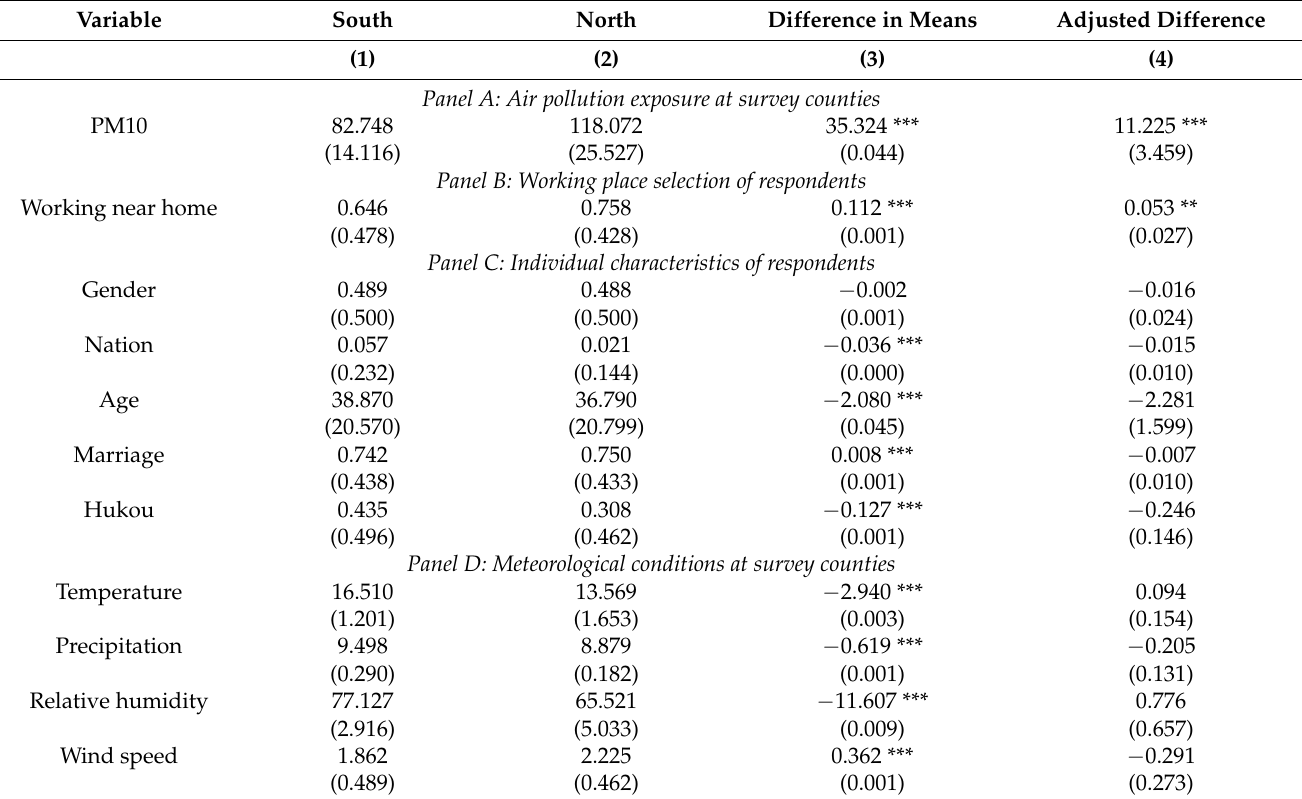
Table 1. Summary statistics, means, and standard